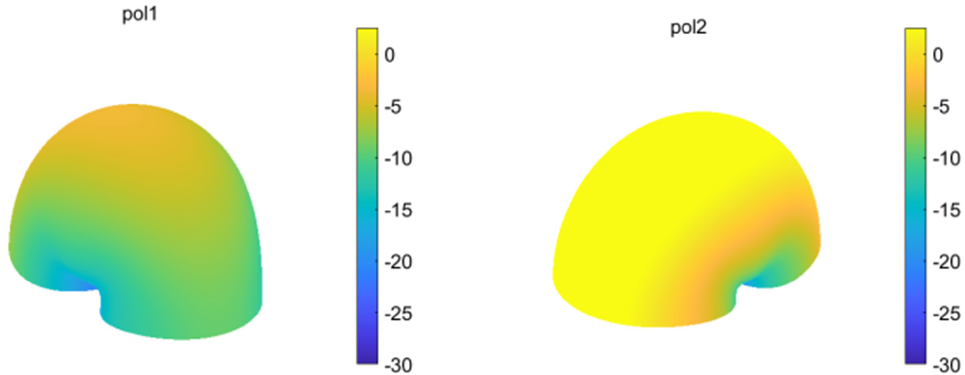
Figure 1. Radiation direction diagram of the RIS unit.